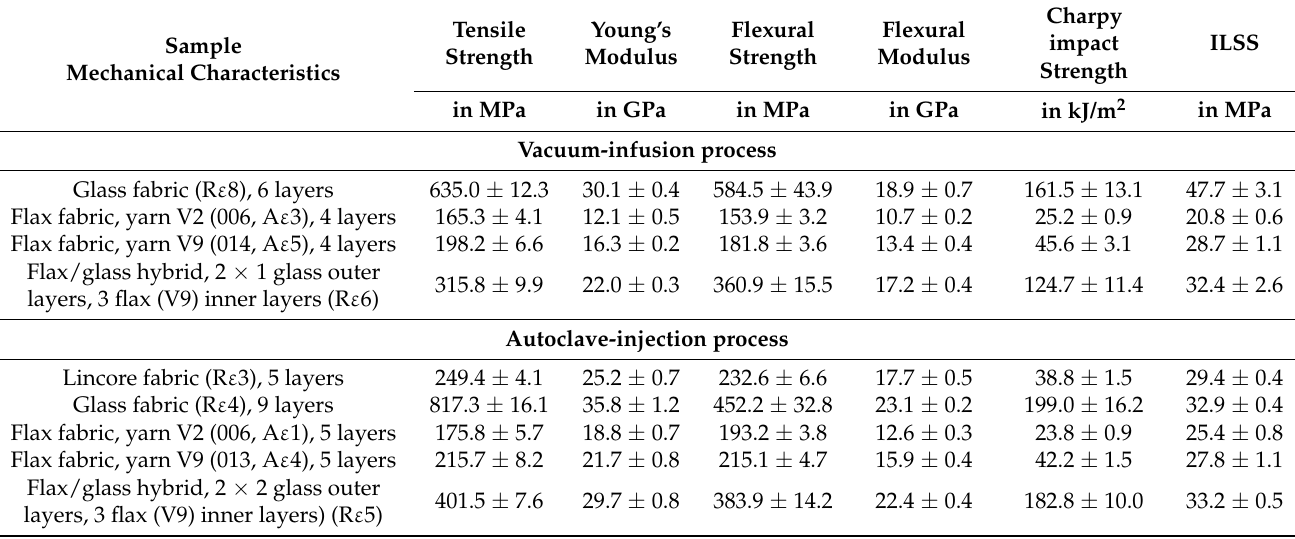
Table 5. Comparison of mechanical characteristics of composite laminates (mean values ± standard deviation) (designations in brackets with Greek letters indicate internal labels which are used for the classification of the samples in the